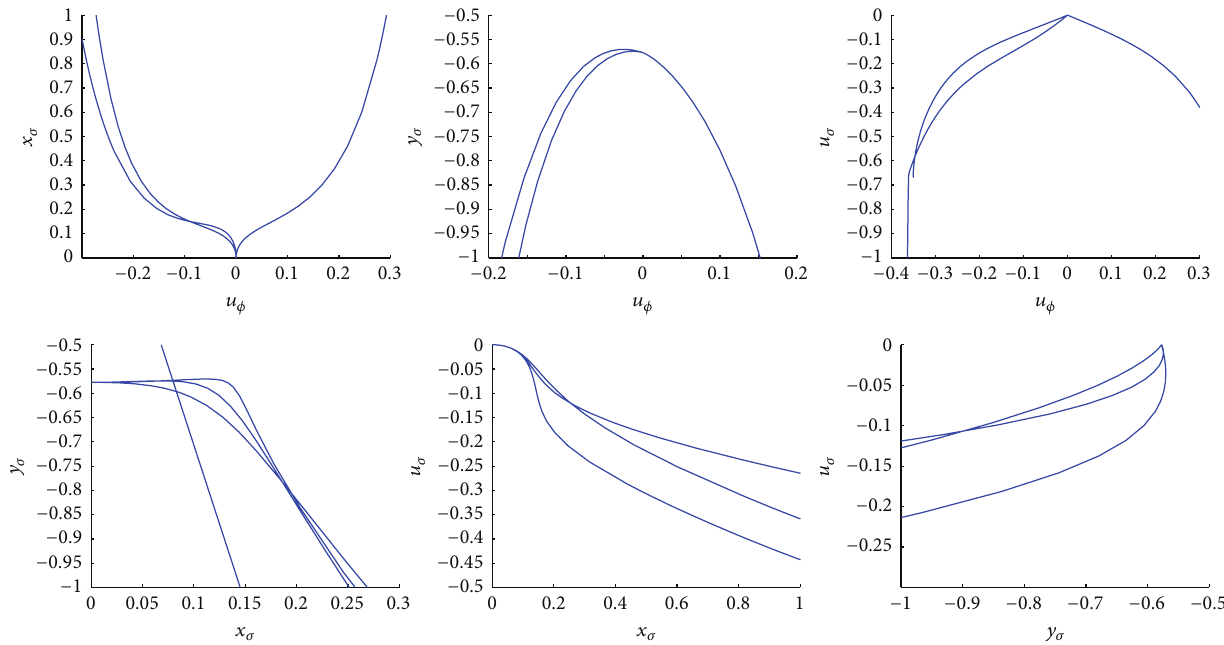
Figure 4: Two-dimensional projections of the phase-space trajectories for 𝜉 1 = 𝜉 2 = 𝜉 3 = −0.5 , 𝛼 𝜓 = 𝛼 𝜙 = 𝛼 𝜎 = −1.5 . All plots begin from the critical point 𝐷 being a stable